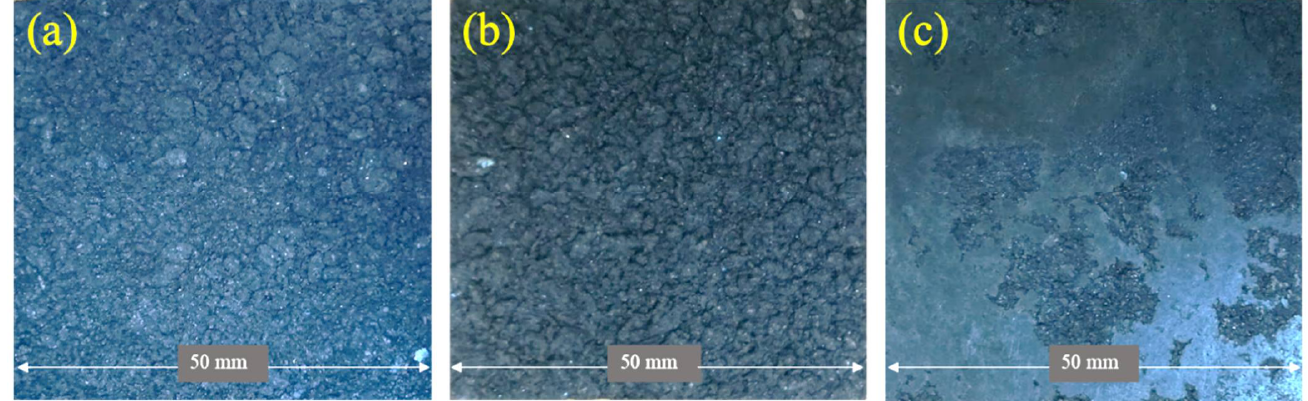
Figure 2. Surface of the water-soaked samples for 24-h: ( a ) WPC-1, ( b ) WPC-2, ( c ) WPC-3.